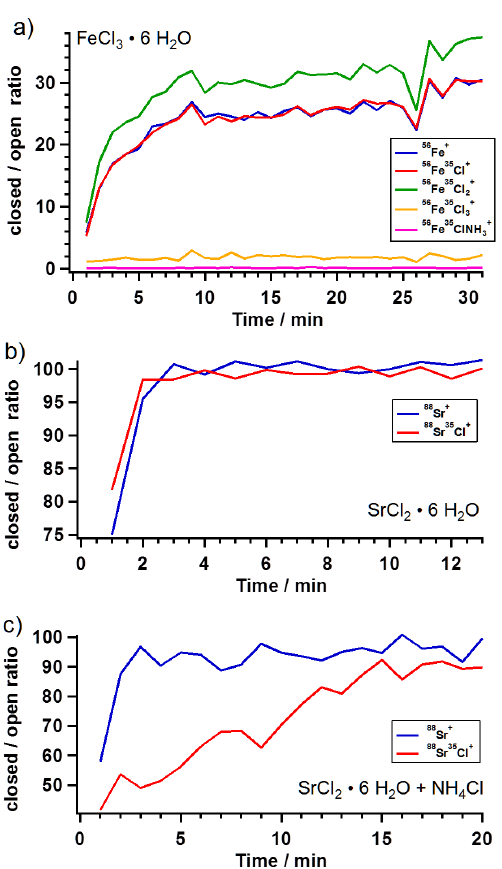
Figure 5. Ratio of instrument background to aerosol beam measurement intensity (c / o ratio, in percent) for ions from FeCl 3 · 6 H 2 O (a) , from pure SrCl 2 · 6 H 2 O (b) , and from a mix- ture of SrCl 2 · 6 H 2 O and NH 4 Cl (c) for the first minutes of aerosol measurement. Uncertainty of the measurements is